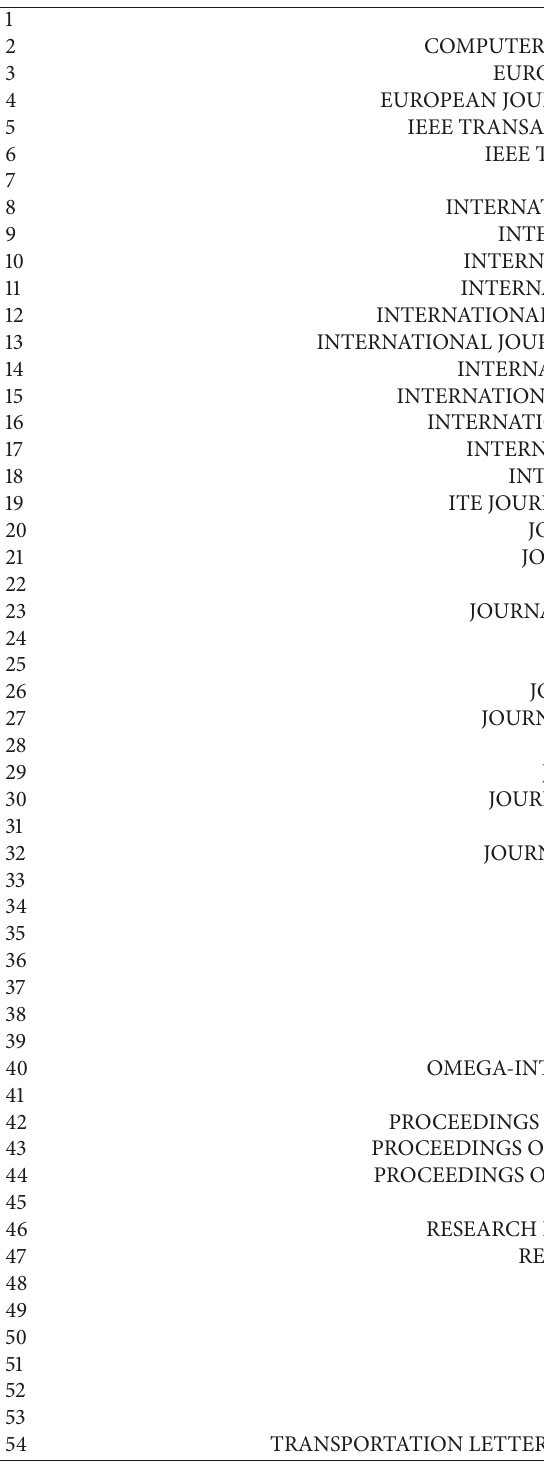
Table 5: 65 journals